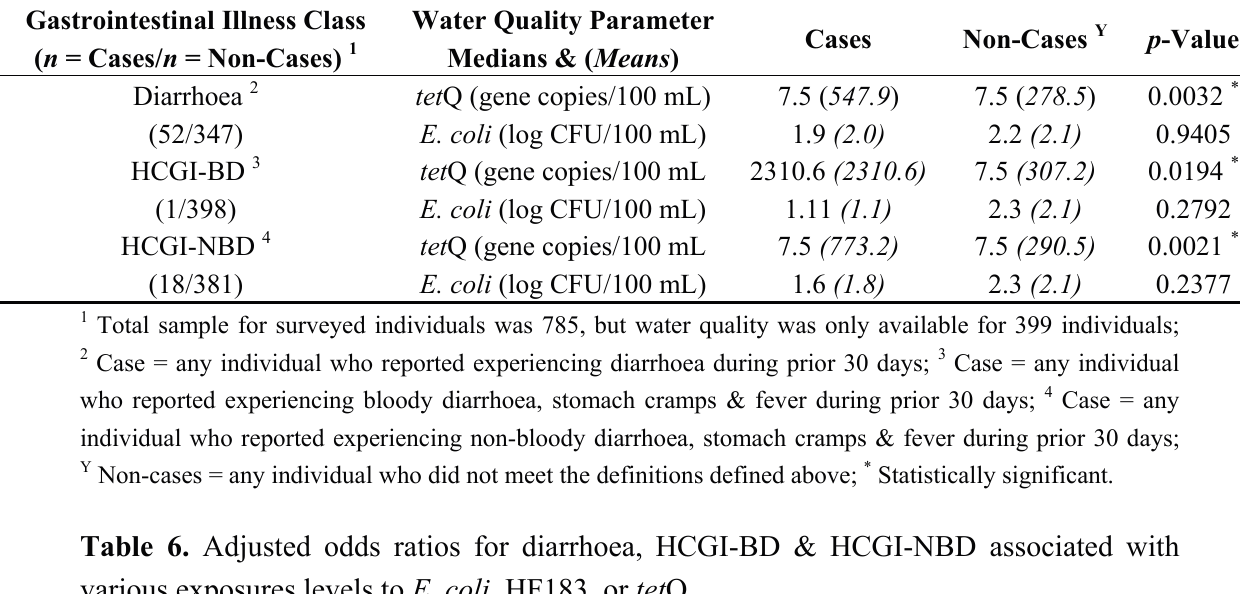
Table 5. Results of Mann-Whitney U tests of E. coli and tet Q concentrations between